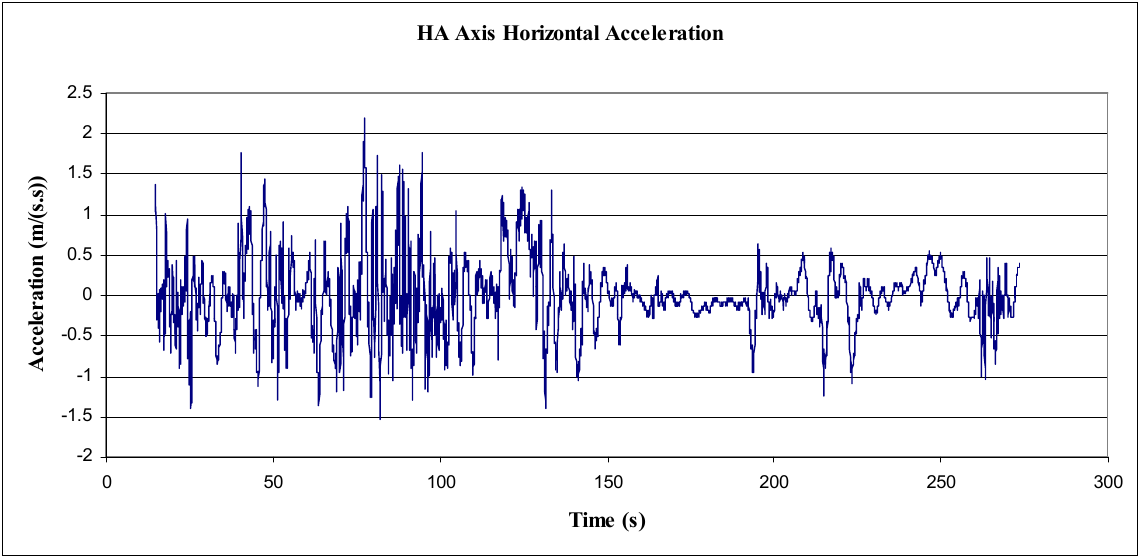
Figure 14. Acceleration in horizontal axis, A (time 15 to 273 s).